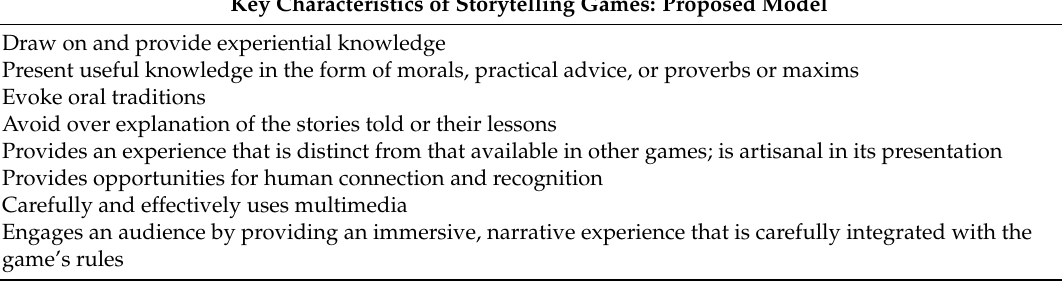
Table 2. A possible adaptation of Benjamin’s storytelling characteristics for the development of immersive game